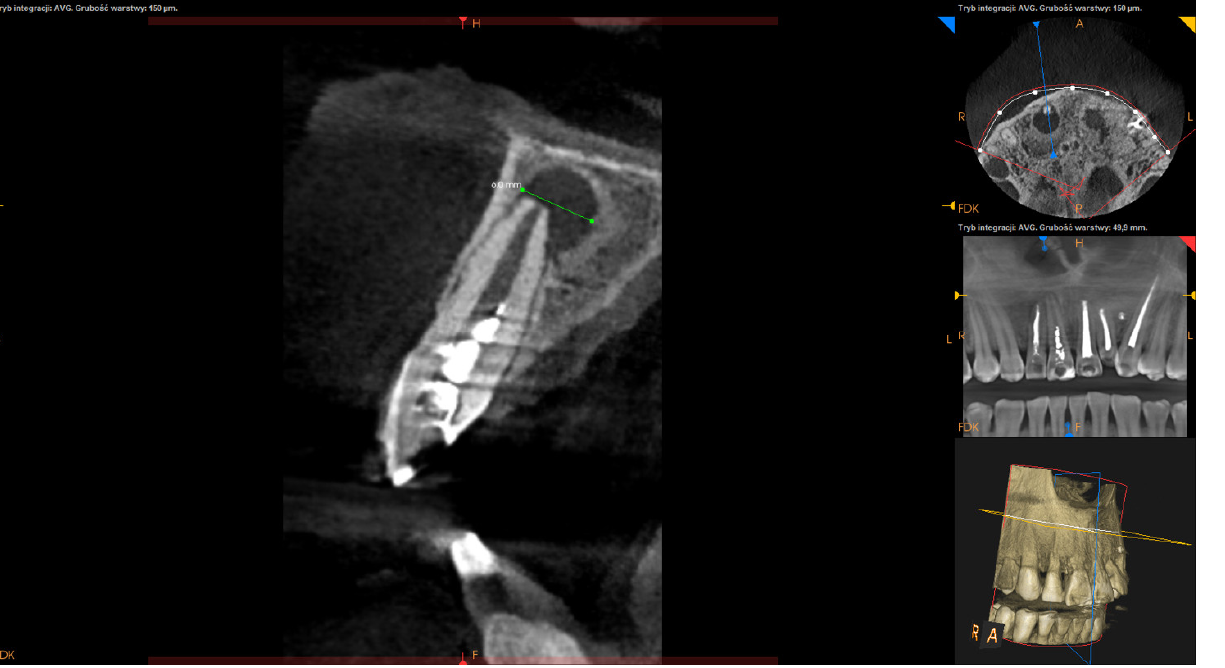
Figure 2. CBCT image (CS 8100 3D Carestream Dental ® ) measurement of apicocoronal maximum diameter in sagittal section. Non-English annotations present software technicalities (AVG integration mode and the layer thickness).